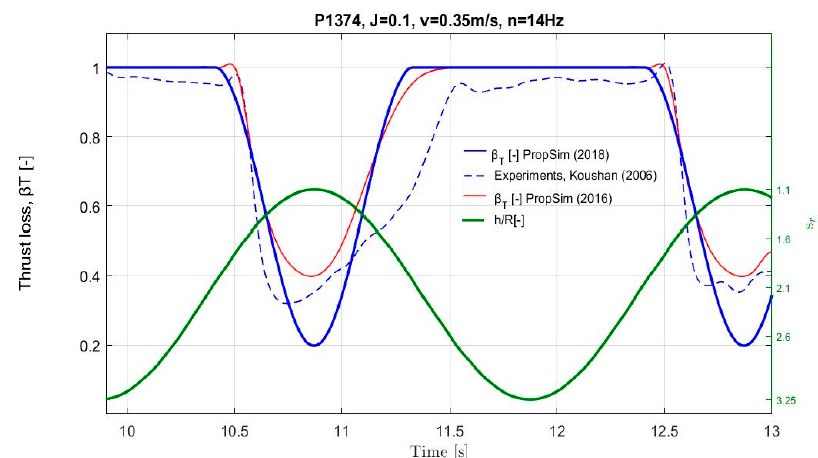
Figure 3. Comparison of thrust loss between simulation performed by using the PropSim (2016) simulation model, PropSim (2018) simulation model, and experimental results of Kou 2006_I , the sampling rate is above four times the propeller revolutions, and it is equal to 60 Hz.